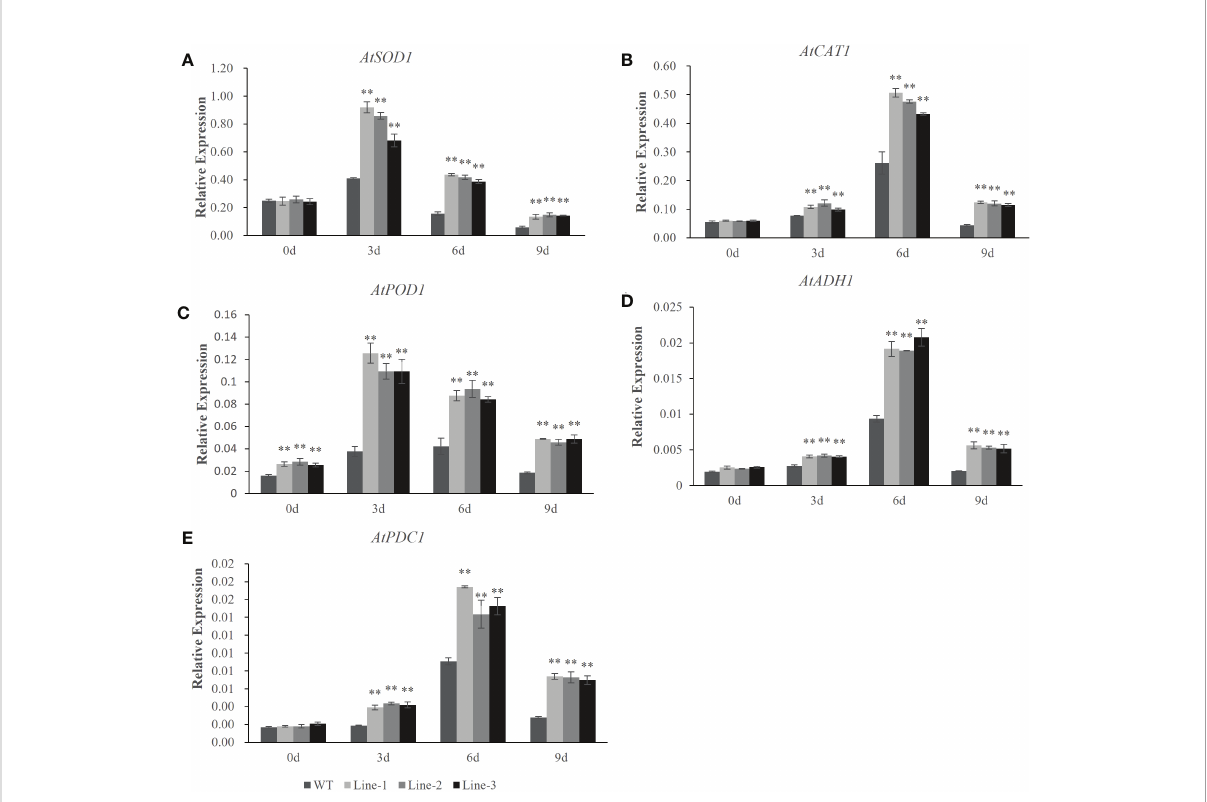
FIGURE 7 Expression analysis of stress-responsive genes in HvERF1 overexpression lines and WT under waterlogging stresses. The relative expression levels of stress-responsive genes (AtSOD1, AtCAT1, AtPOD1, AtADH1, AtPDC1) were determined by qRT-PCR (A – E) . After 3 days, 6 days, 9 days waterlogging treatments, respectively. Seedlings harvested before treatment were used as control. Relative expression levels of these fi ve genes were normalized to the transcripts of AtActin in the same samples. The mean value and standard deviation were obtained from three independent experiments. The data represent mean ± SD of three biological repeats with three measurements per sample. Asterisks indicate signi fi cant differences between transgenic plants and WT according to Student ’ s t-test (** p <